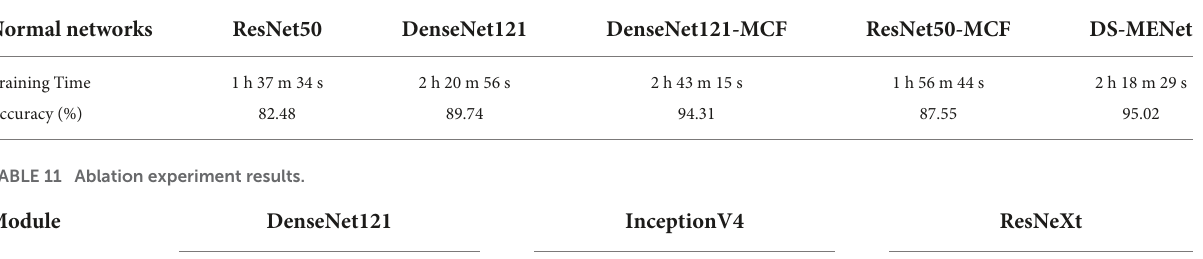
TABLE 10 Verifying the effectiveness of the MCF backbone enhancement method.